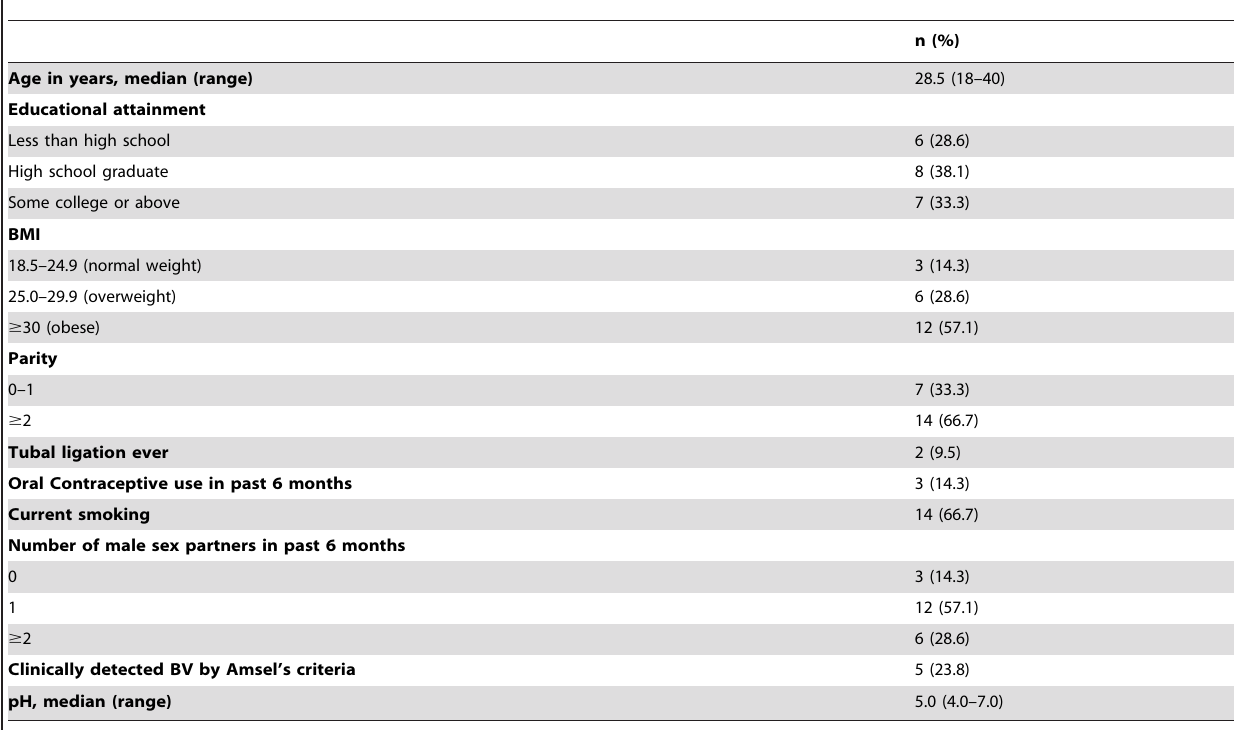
Table 1. Subjects’ Characteristics at Index Visit, N=